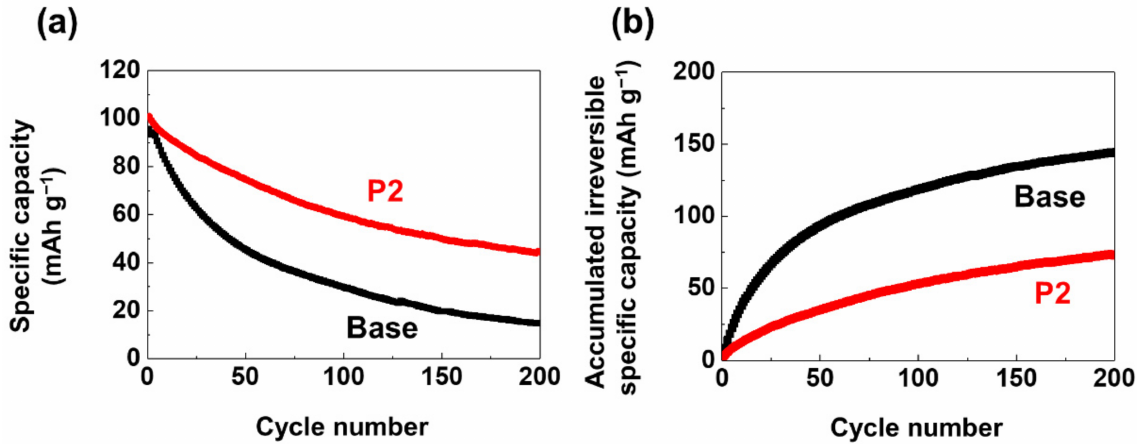
Figure 2. ( a ) The cycle performance and ( b ) accumulated irreversible specific capacity of LMO/graphite cells at 60 ◦ C. The cells were charged and discharged at a 0.5 C